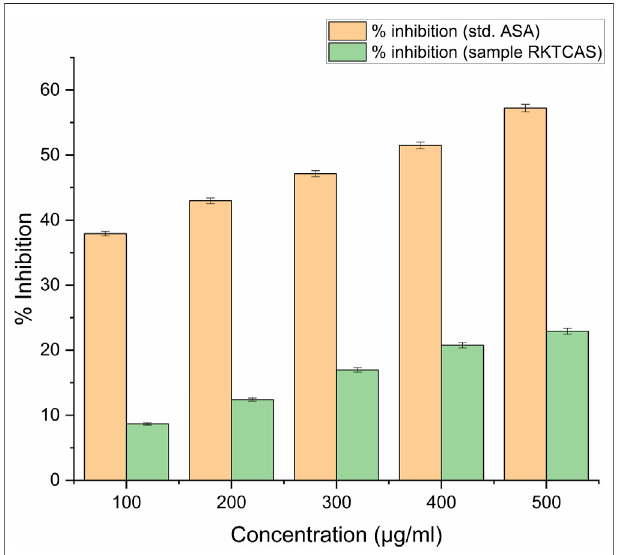
FIGURE 6 | In-vivo anti-arthritic activity (Paw diameter in mm) n (cid:2) 6; Data (cid:2) Mean ± SEM;** p < 01(G2VsG4);*** p < 0.001(G2vs.G3,G4andG5).